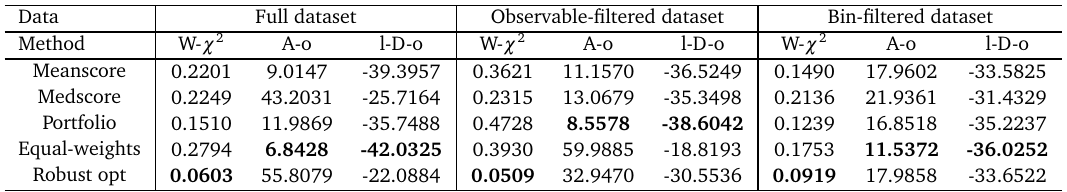
Table 9: Results for the comparison metrics for the full, observable-filtered, and bin- filtered S HERPA dataset using the rational approximation. The best results are in bold. In each dataset, W- χ 2 refers to the Weighted χ 2 metric, A-o refers to the A-opt metric, and l-D-o refers to the log D-opt